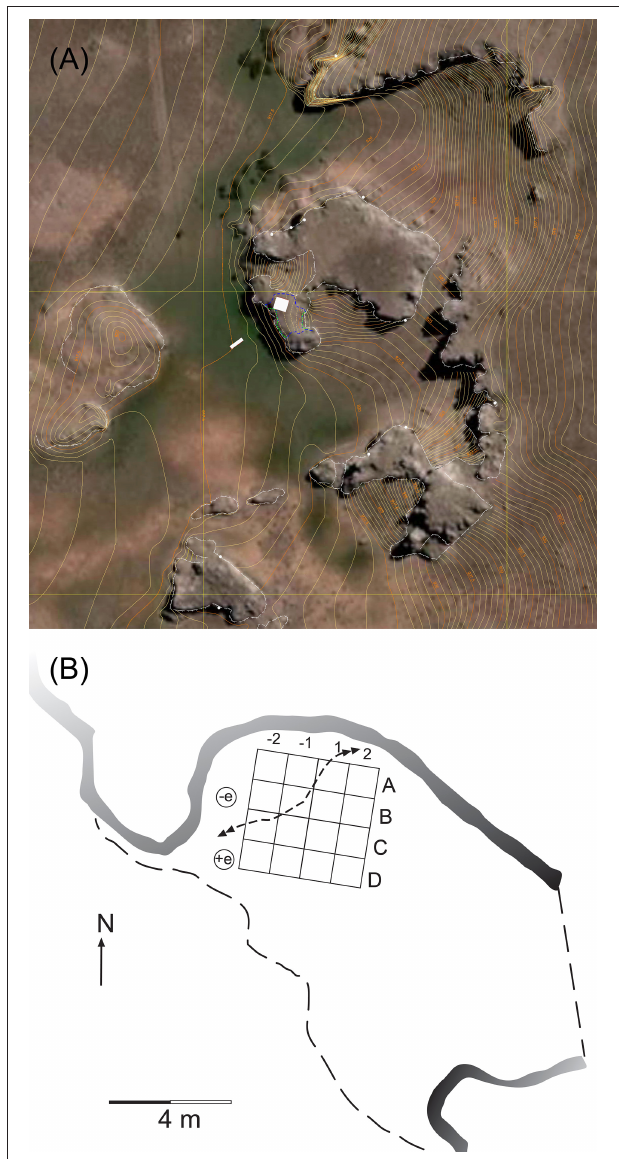
FIGURE 6 | (A) General view of El Chueco 1 site, (B) excavation plan.